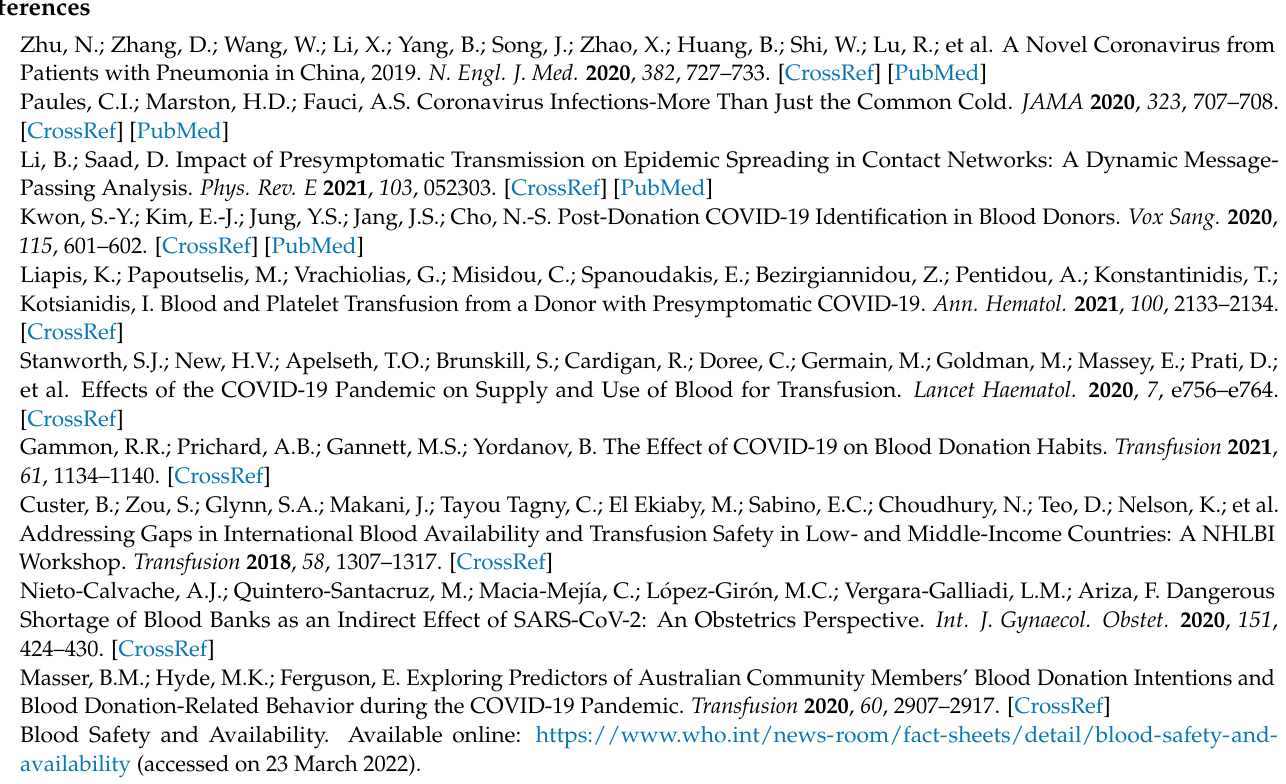
Table S2: Correlation of scales of attitude and behavior, opinions and suggestions on blood donation, and fear and anxiety related to COVID-19 of study participants (* p < 0.05); Table S3: Correlation of scales of attitudes and behaviors, opinions and suggestions on blood donation, and fear and anxiety related to COVID-19 in terms of characteristics of study participants (* p < 0.05); Questionnaire: Study of views and attitudes of blood donors toward blood donation during the COVID-19